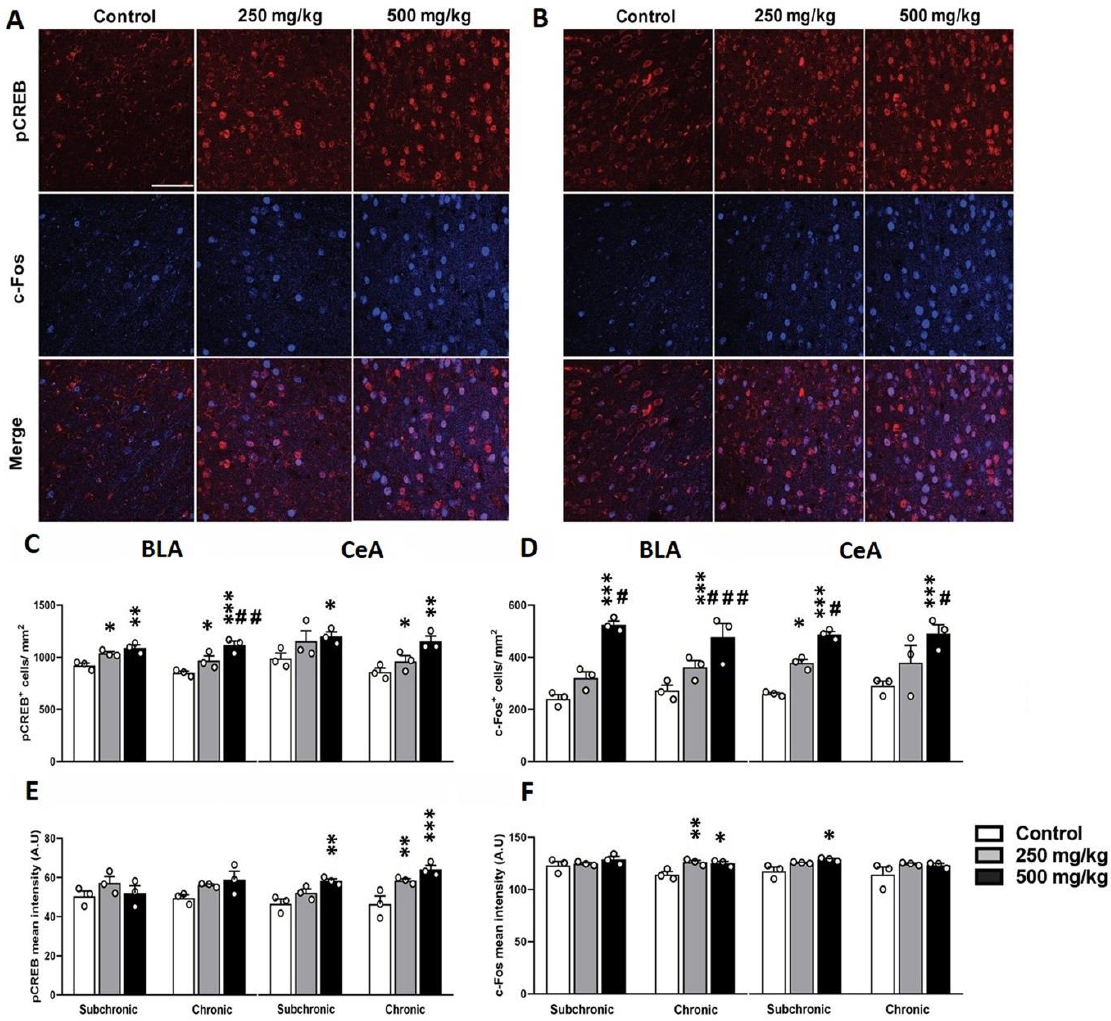
Figure 3. Effect of GBH on the pCREB and c-Fos expression in the amygdala. Representative confocal images illustrating pCREB + and c-Fos + distribution in the BLA ( A ) and the CeA ( B ) from animals who were chronically exposed. Cell density of pCREB ( C ) and c-Fos ( D ). Optical density of pCREB ( E ) and c-Fos ( F ). * p < 0.01; ** p < 0.01; *** p < 0.001. # p < 0.05; ## p < 0.01; ### p < 0.001. * indicates comparison between control vs. 250 mg/kg and 500 mg/kg groups; # indicates comparisons between 250 mg/kg vs. 500 mg/kg group. Scale bar: 10 μm.